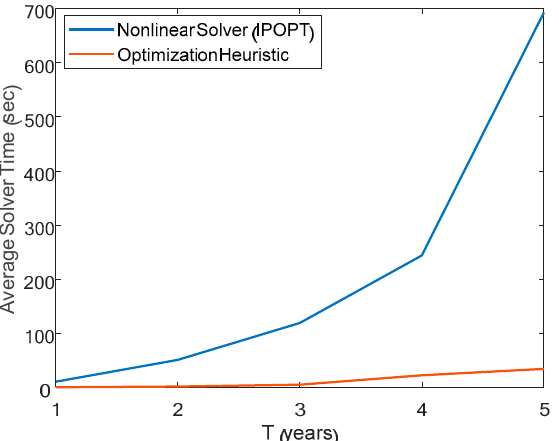
Figure 4. Average solution time for T = 1...5 without solver time